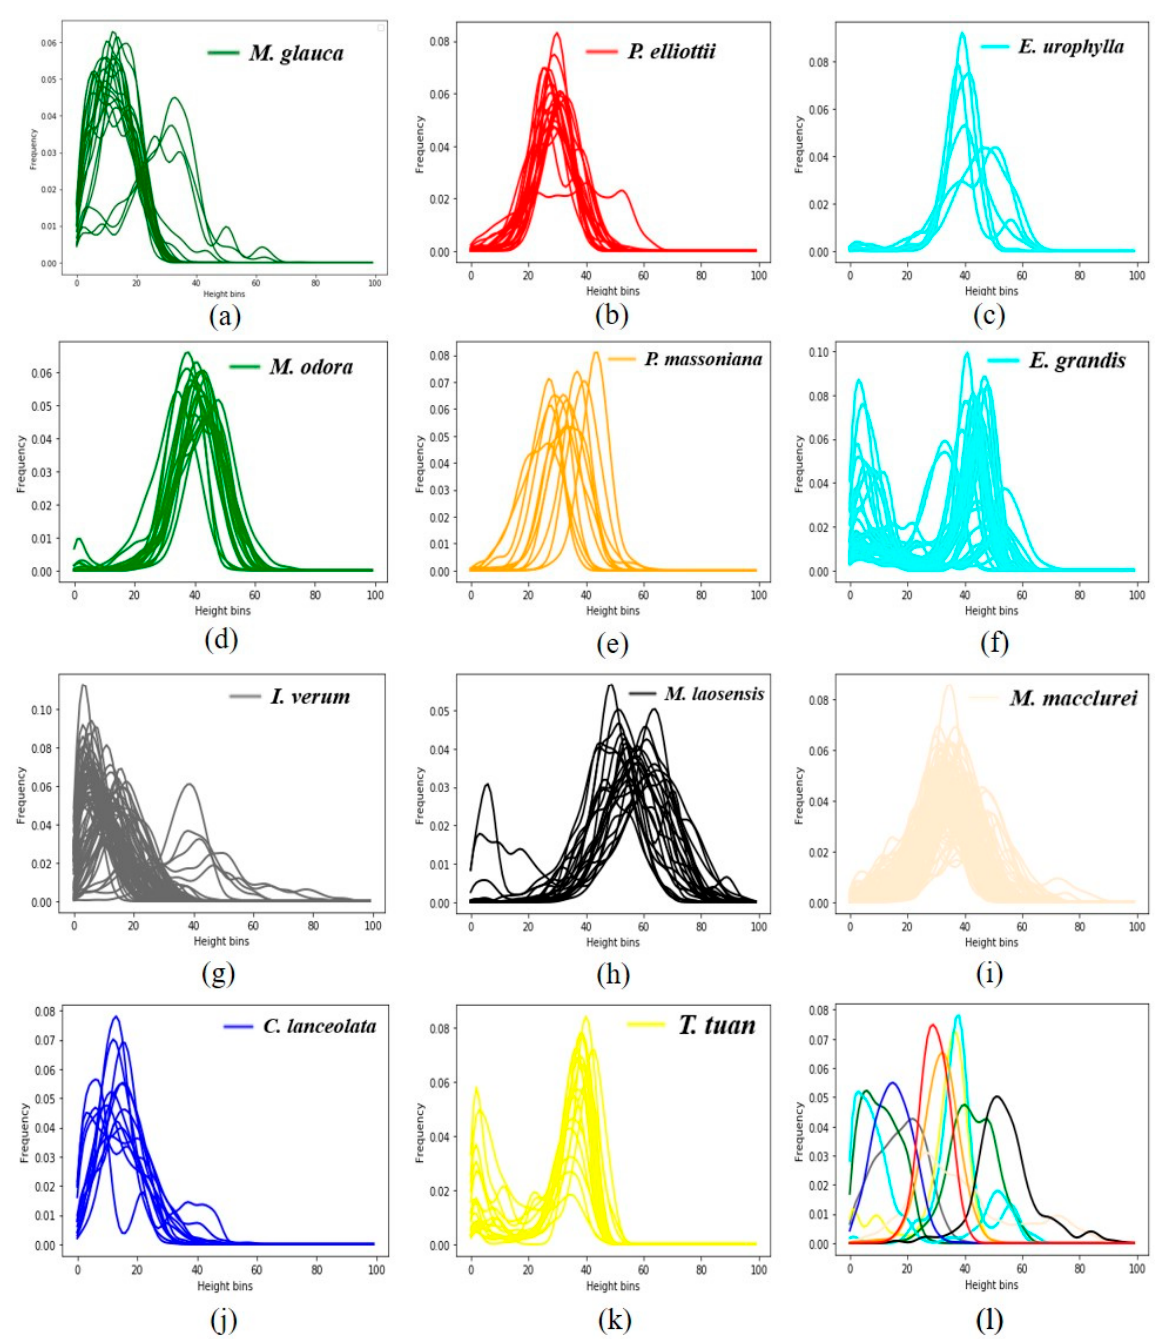
Figure 14. ( a – k ) The profile curve generated by the LiDAR data of 11 tree species and ( l ) a comparison chart of the curves for 11 tree species.